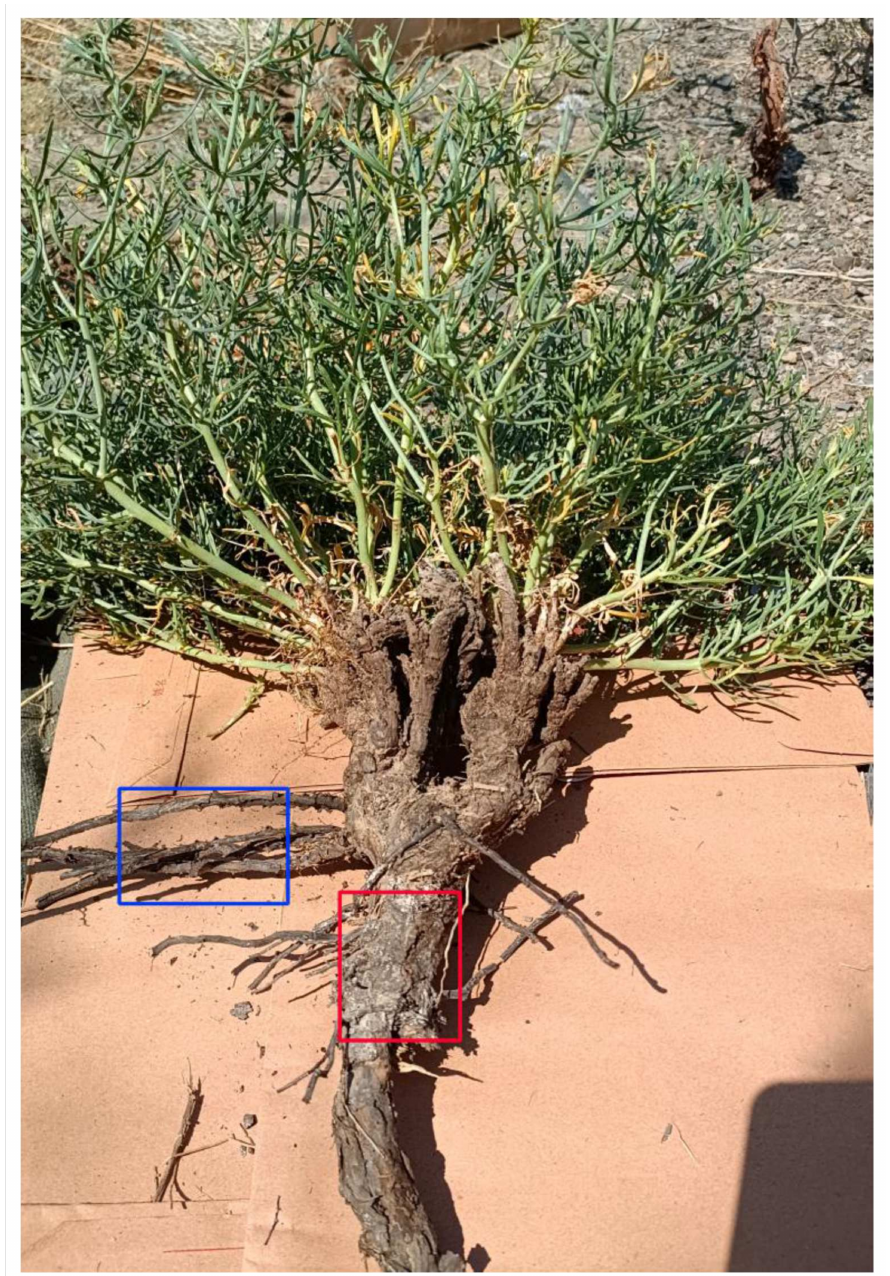
Figure 2. Picture of the study material ( Peganum harmala ). The red box indicates the intercepted part (taproot), and the blue box indicates the lateral